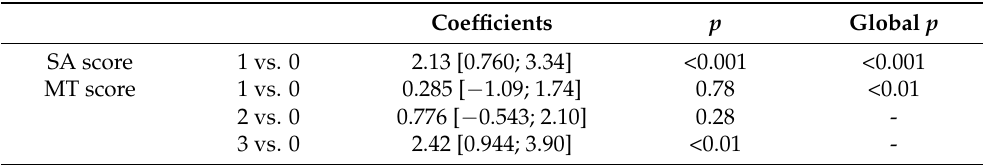
Table 2. Multivariate analysis of time to disclosure as a function of SA and MT scores (SA: Sexual abuse; MT: